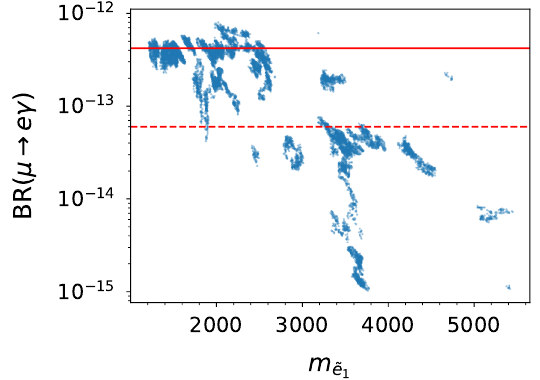
. Current experimental limit is represented by the red Figure 16 . BR ( µ → eγ ) as a function of m ˜ e 1 solid line while the dashed one corresponds to the future prospects of MEG II ( 6 · 10 − 14 ) [91]. limits are even weaker if this is not the case). In addition, current exclusion on τ flavoured sleptons masses are of order 390 GeV